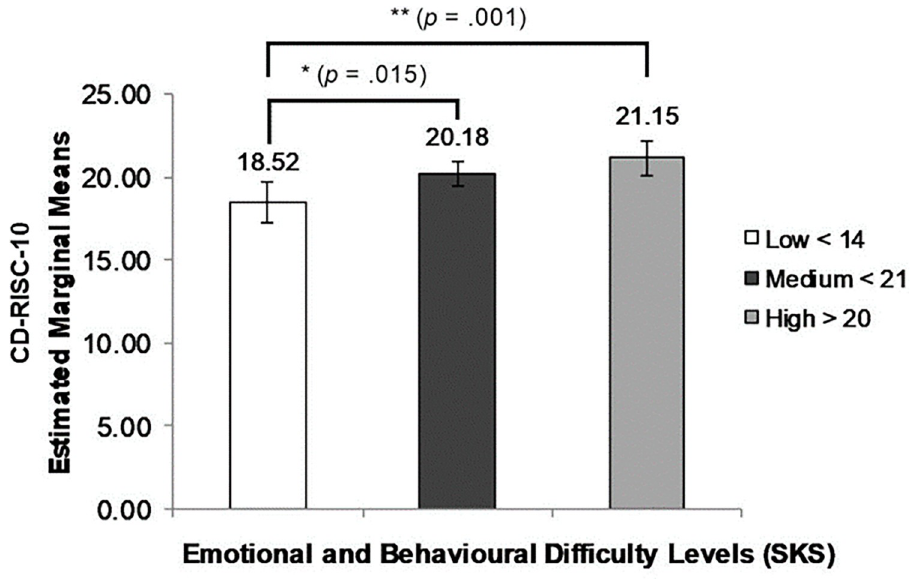
Fig 3. ANOVA results: CD-RISC-10 resiliency scores by level of emotional and behavioural difficulty (SKS).